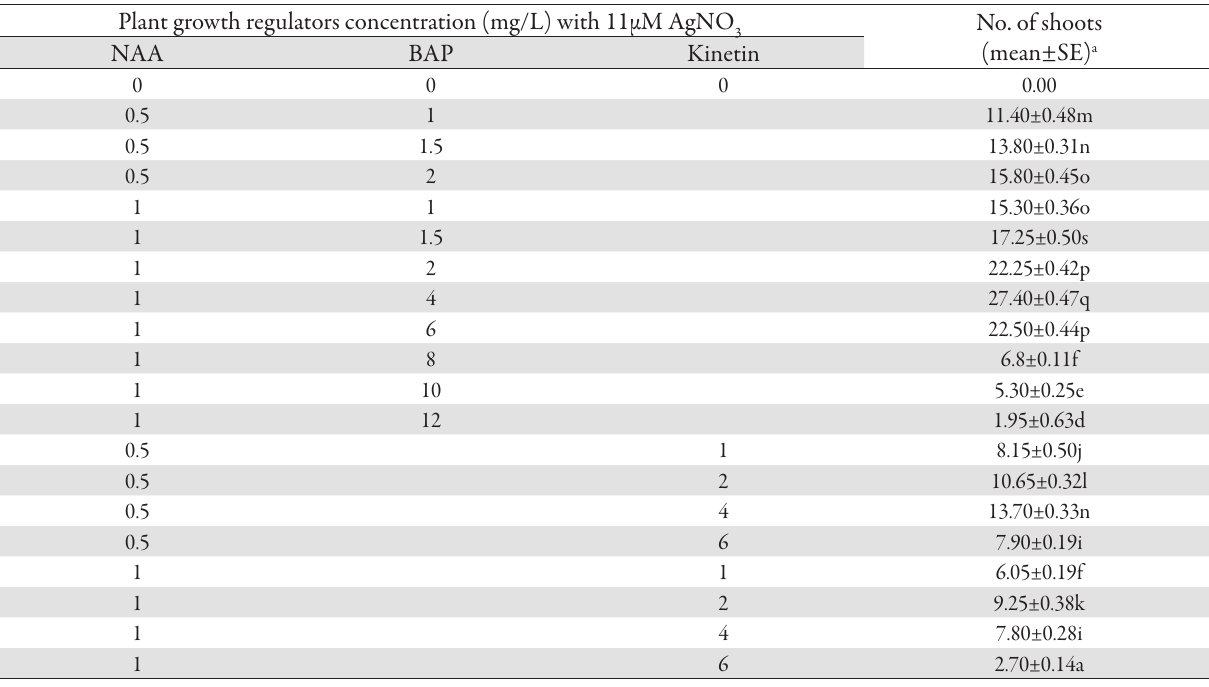
Tab. 2. Effects of different hormones and AgNO Plant growth regulators concentration (mg/L) with 11µM AgNO